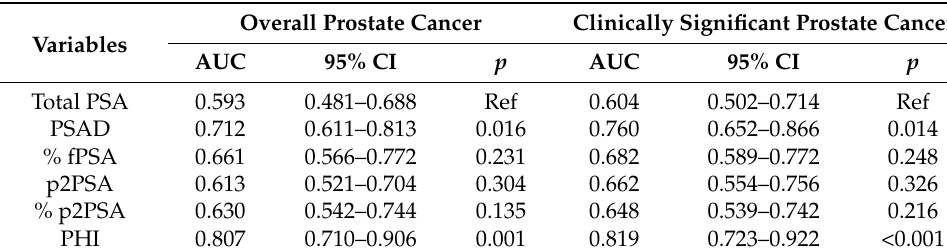
Table 2. Comparison of the AUC of PSA derivatives, based on total PSA in patients with PI-RADS v2 score-3 lesions, for the detection of overall and clinically significant prostate cancer.